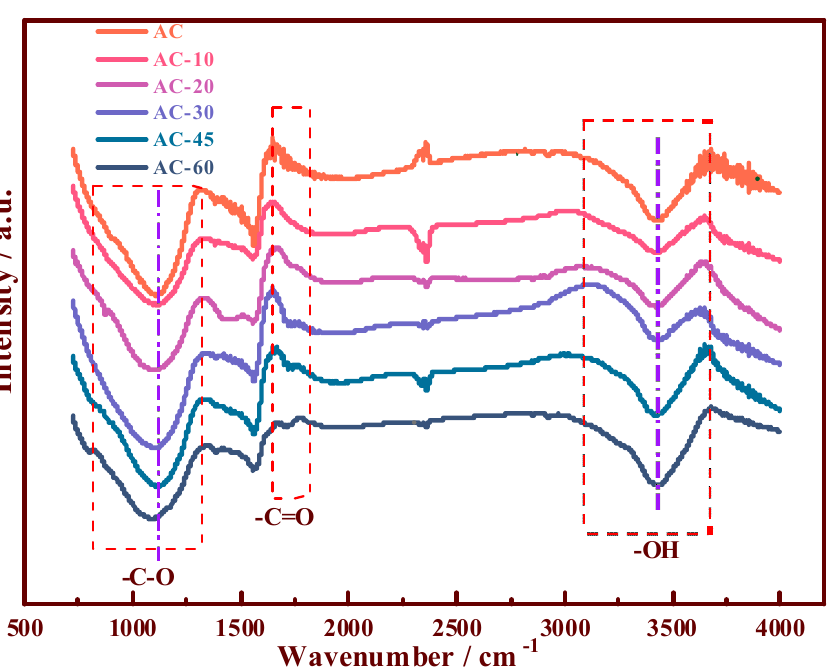
Figure 2. FTIR spectra of the support samples of the prepared AC and ozone-pretreated AC-10, AC-20, AC-30, AC-45, and AC-60.